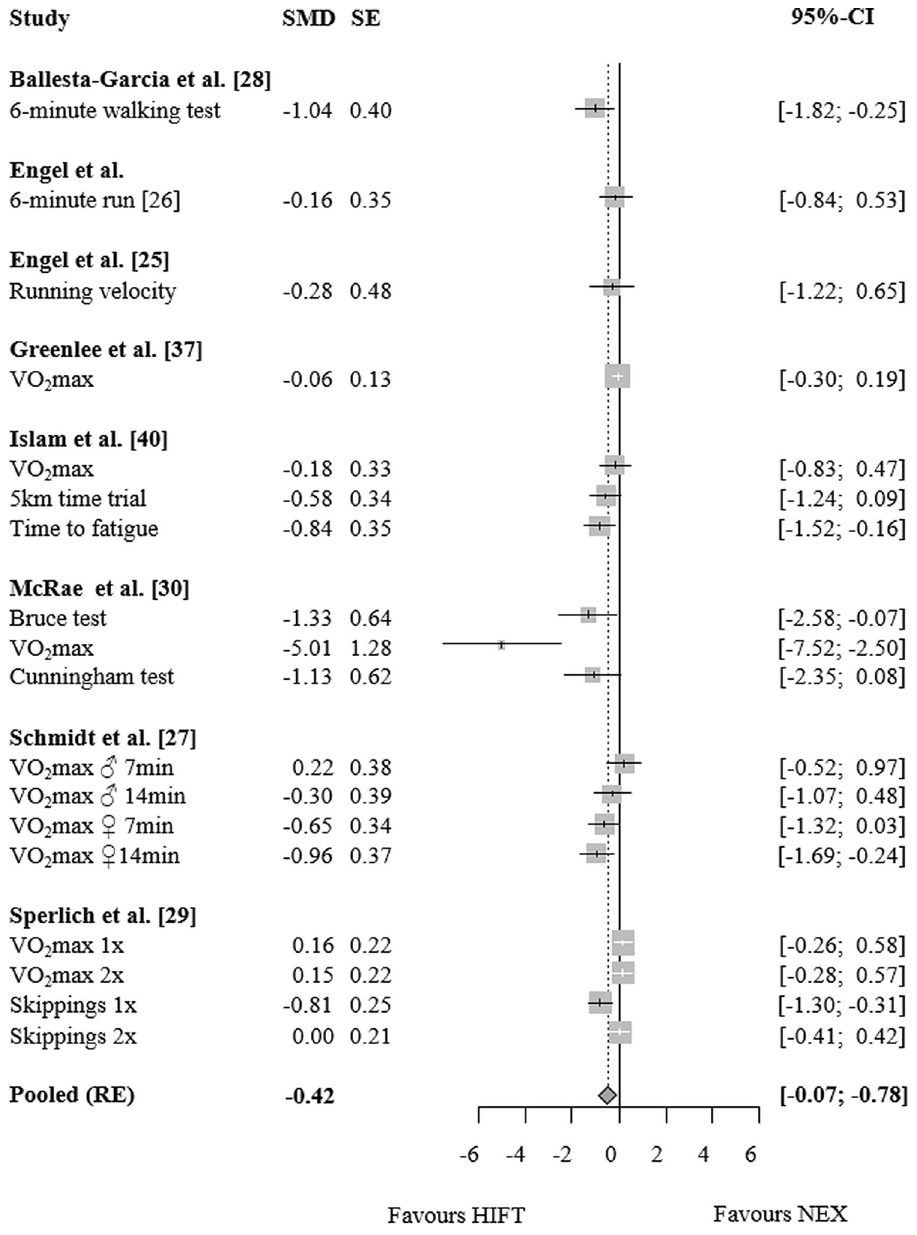
Figure 2. Effects of high-intensity-functional training (HIFT) vs. no exercise (NEX) on markers of endurance performance. Forest plots with pooled standardized mean differences (SMD), standard errors (SE) and 95% confidence intervals (CI) are displayed. RE random